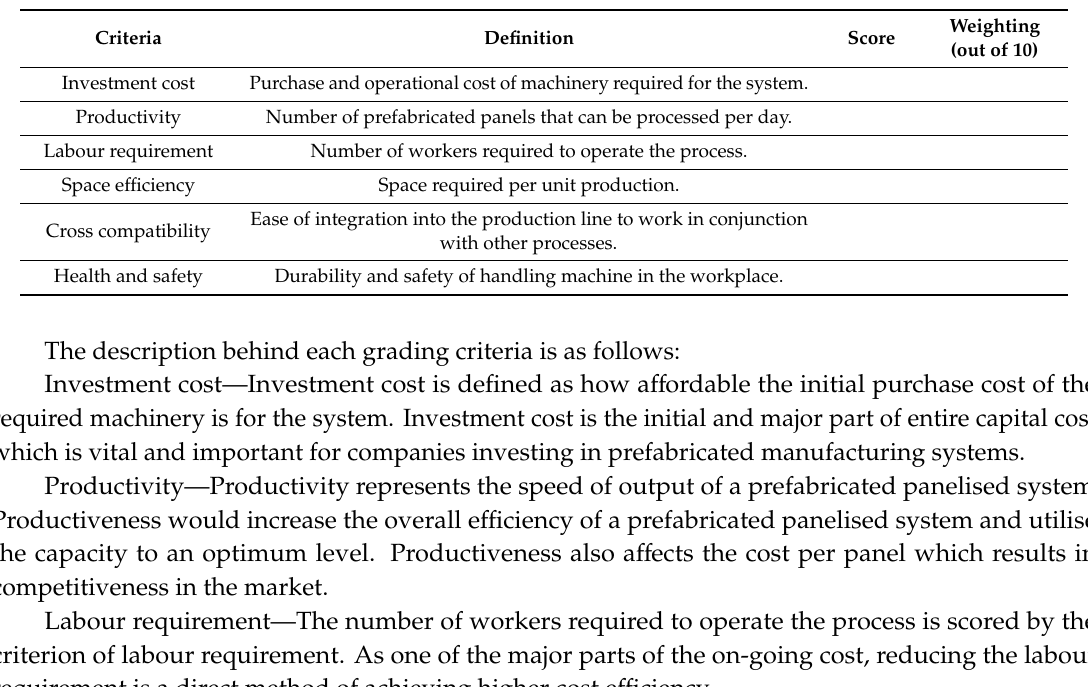
Table 1. Summary of grading critria used for the